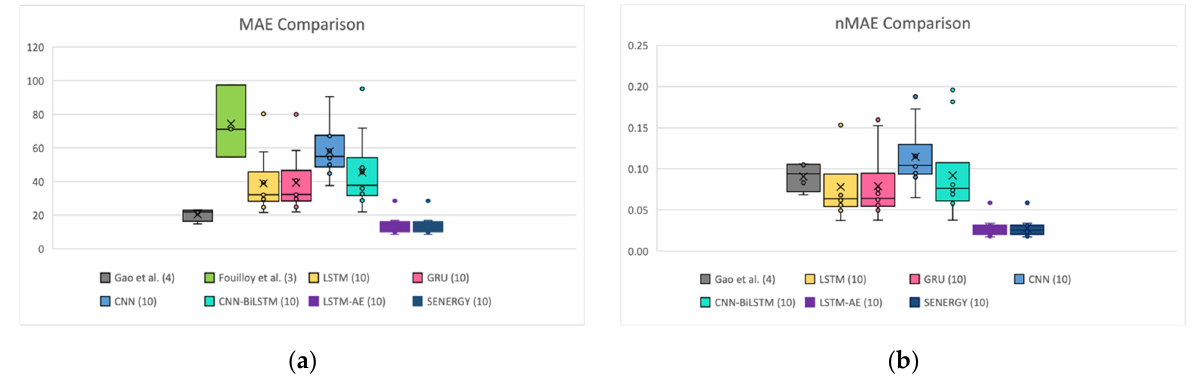
Figure 44. Comparison of multiple works based on: ( a ) MAE; ( b ) nMAE.